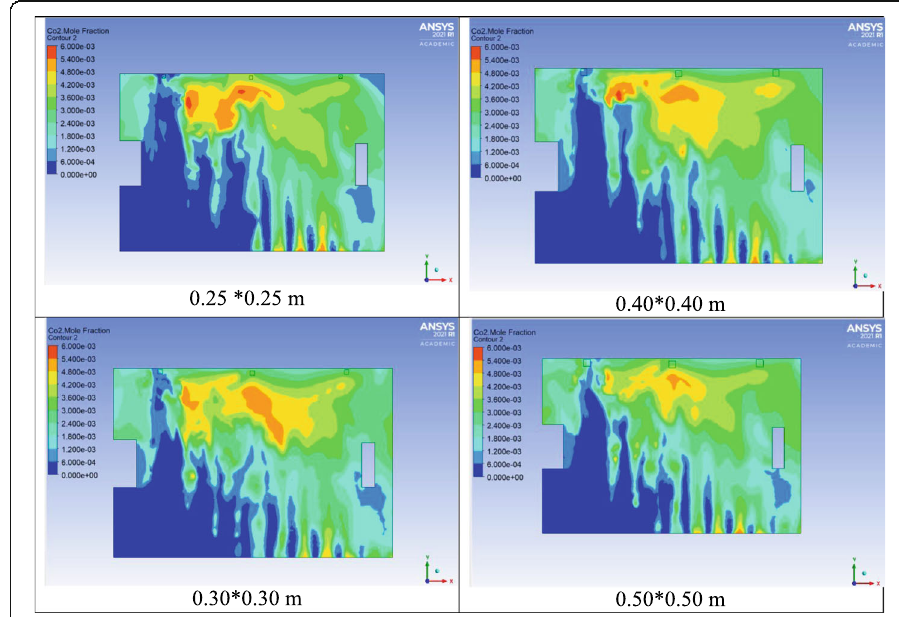
Fig. 8 Contours of CO 2 concentrations (ppm) for cross-section squares at the breathing level zone (1.2 m), output from the ANSYS CFD model